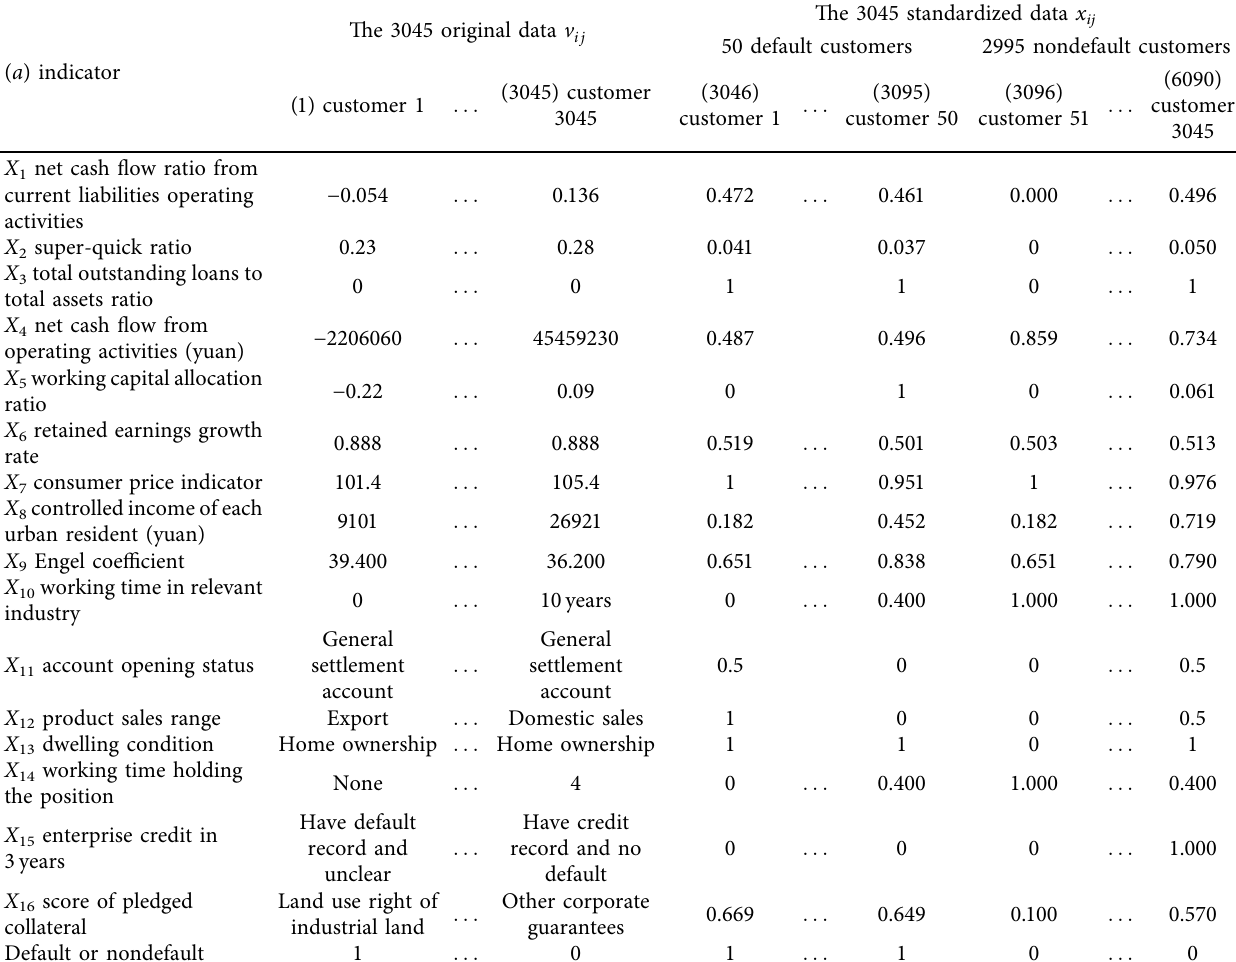
Table 4: The original data and standardized data of 16 indicators of small enterprises.